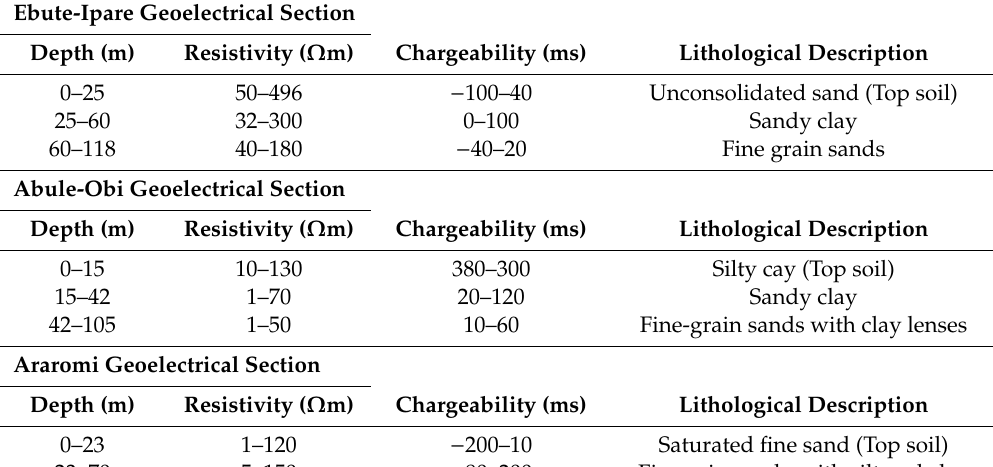
Figure 10. Inverted resistivity and IP cross-sections Araromi (Profile section P6). Table 5. Lithological interpretation of geoelectrical sections from Profile B – C.